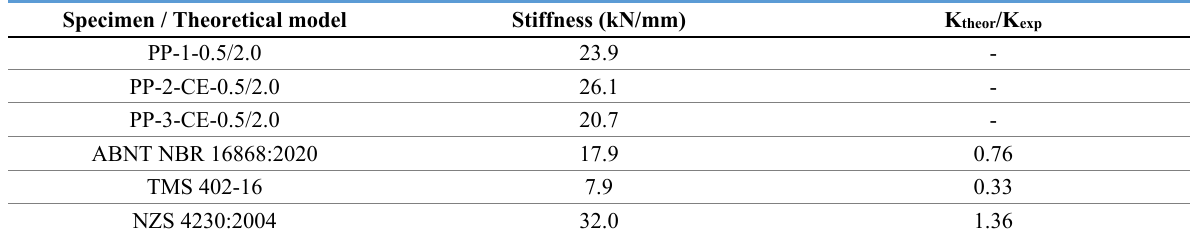
Table 2. Relative lateral stiffnesses for experimental tests and theoretical methods.